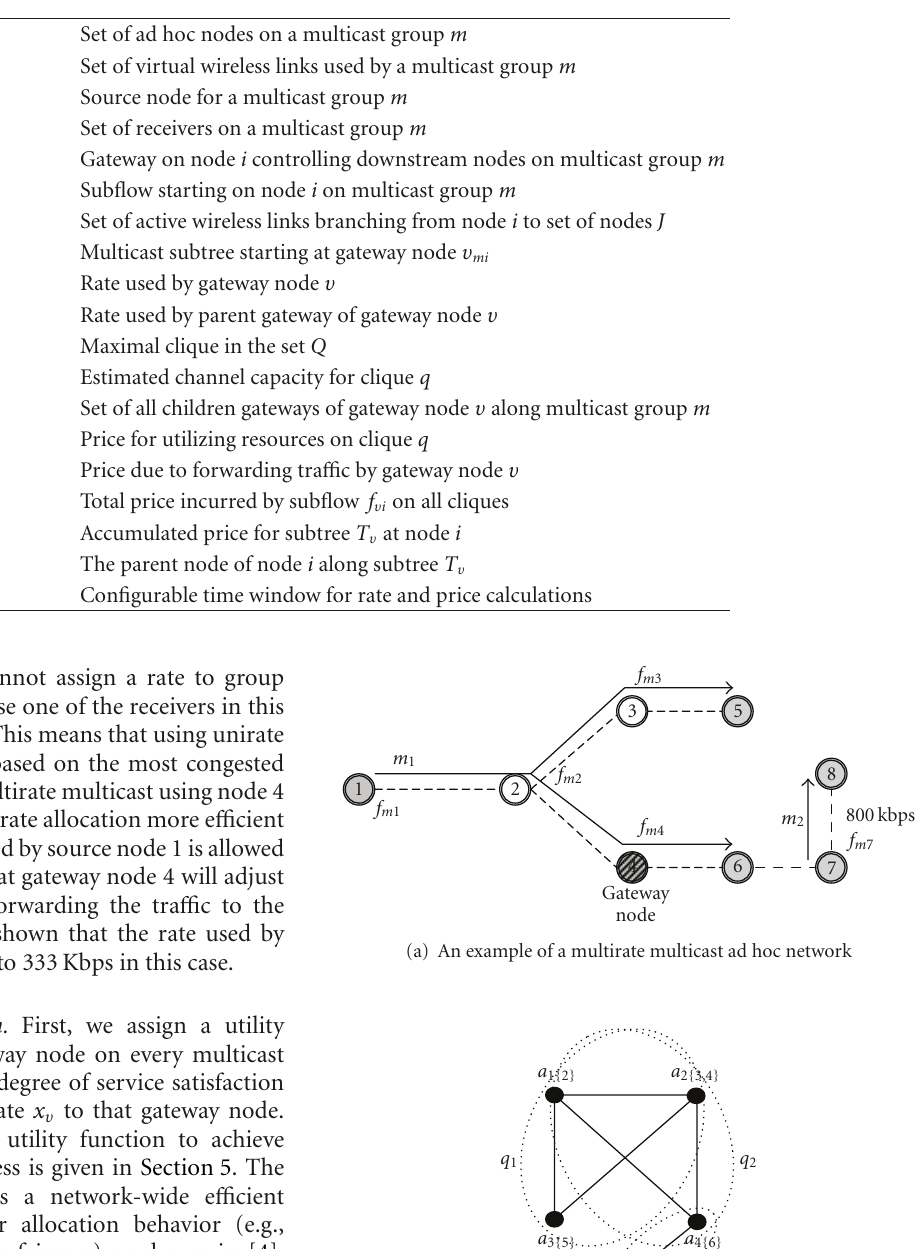
Table 1: Notations used by heterogeneous multicast model.